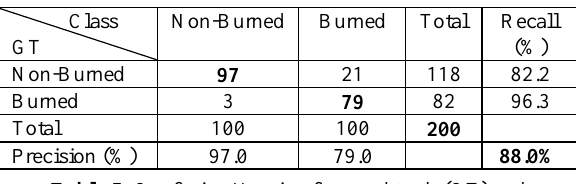
Table 5 . Confusion Matrix of ground truth (GT) and classification (Class) for the use case example in Central Africa using the local model. The bottom right cell displays the overall accuracy. The F 1 -score for non-burned is 87.4% and for burned 84.5%.